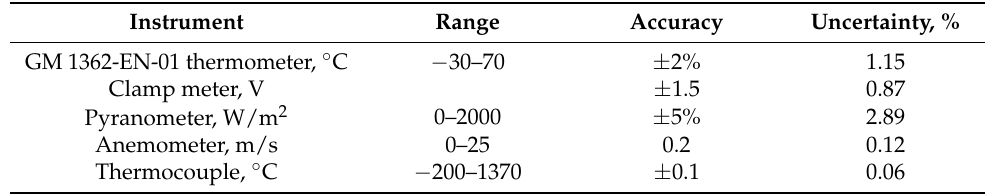
Table 1. Accuracies and uncertainties of various instruments.